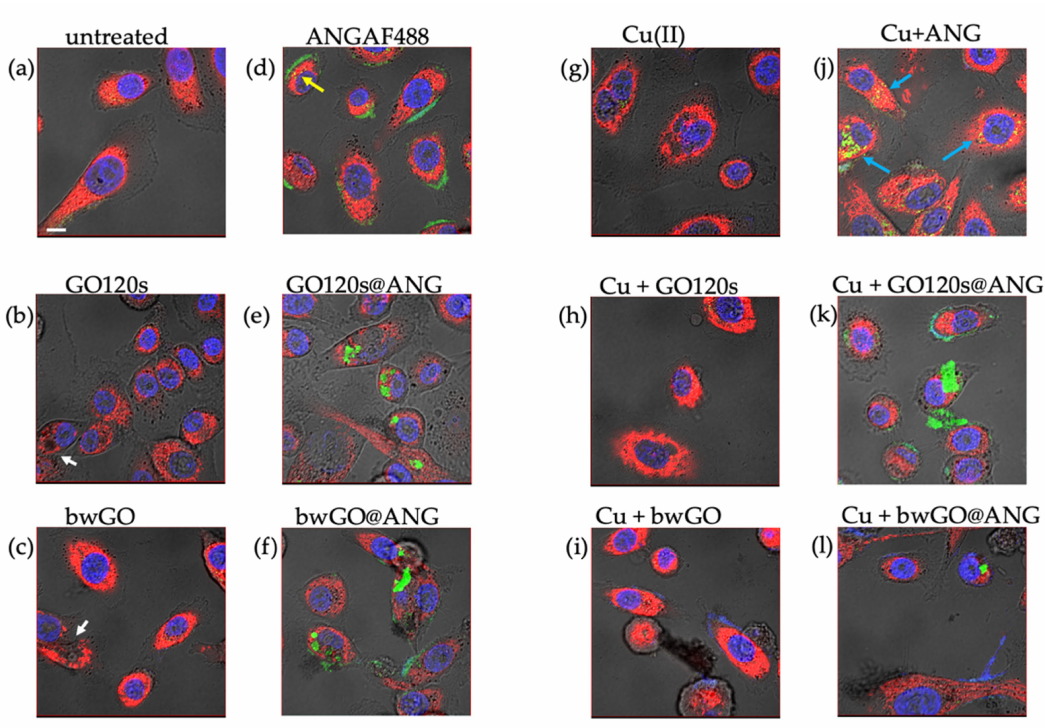
Figure 4. LSM-merged micrographs of optical bright field (in grey) and fluorescence (in blue: nuclear staining, Hoechst, λ ex/em = 405/425–450 nm; in red: mitochondrial staining, MitoTracker Deep Red, λ ex/em = 633/650–655 nm; in green: ANGAF488, Alexa Fluor, λ ex/em = 488/500–530 nm) recorded in live cell imaging of PC-3 cells untreated (( a ): CTRL) and after 24 h of treatment with: 2.78 µ g/mL GO120s ( b ) or bwGO ( c ); 500 nM AngAF488 ( d ); the hybrids (2.78 µ g/mL in GO and 500 nM ANG) of GO120s@ANGF488 ( e ) or bwGO@ANGF488 ( f ); 500 nM CuSO 4 ( g ); 500 nM Cu-supplemented medium with 2.78 µ g/mL of GO120s ( h ) or bwGO ( i ); 500 nM Cu-supplemented medium with ANGAF488 ( j ) or hybrids (2.78 µ g/mL in GO and 500 nM ANG) of GO120s@ANGF488 ( k ) and bwGO@ANGF488 ( l ). Scale bar = 10 µ